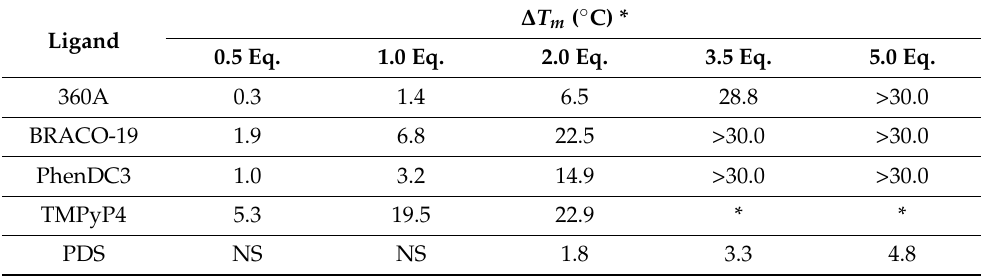
Table 1. Thermal stabilization induced by ligands in the AT11-L2 sequence measured by CD melting experiments.